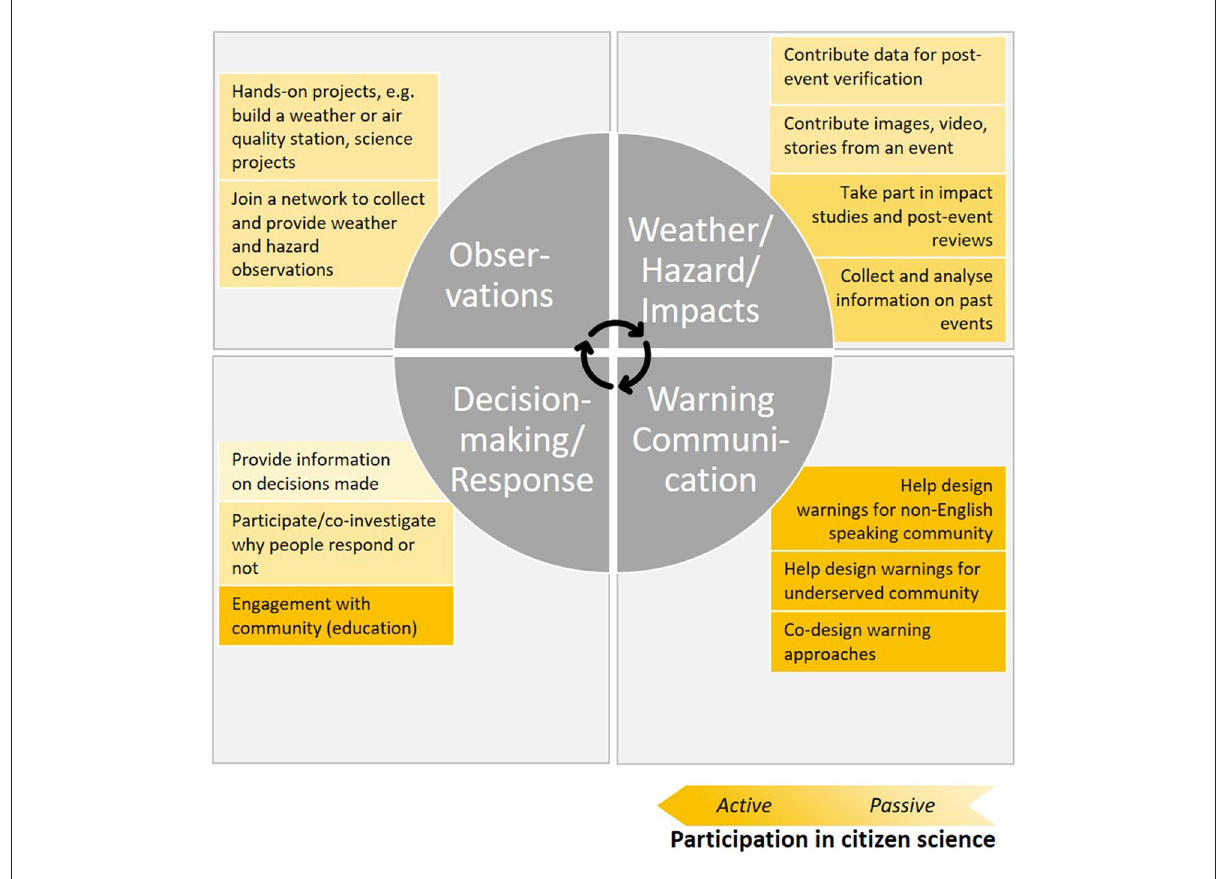
FIGURE5 A visual summary of findings on citizen science contribution to the warning value